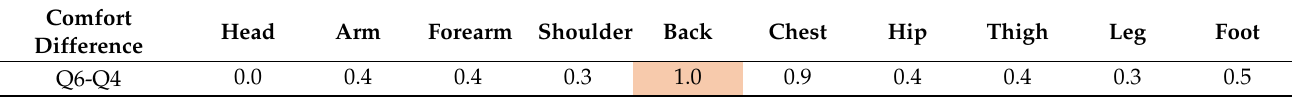
Table 13. Difference between thermal comfort level at Q4 and Q6 for the neutral group.